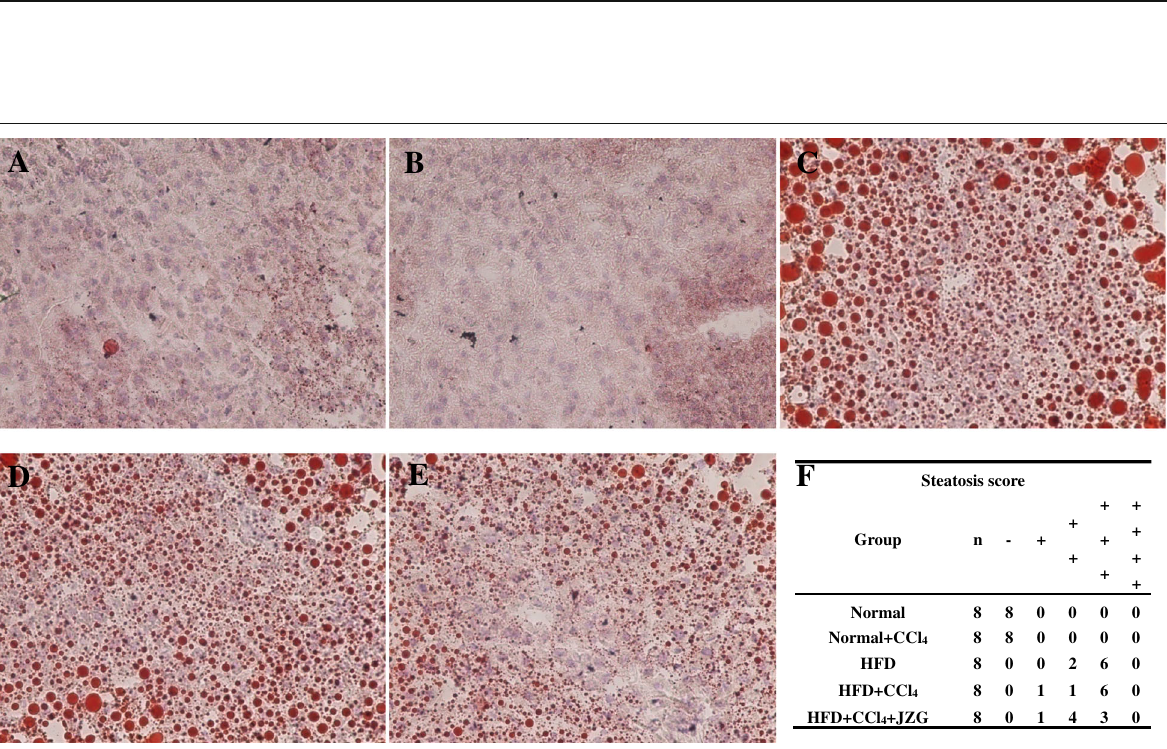
Fig. 3 Effect of JZG on hepatosteatosis: a - e Oil Red O Staining in liver tissue, the original magnification is 200×, a Normal group, b Normal+CCl 4 group, c HFD group, d HFD + CCl 4 group, e HFD + CCl 4 + JZG group, f Steatosis stage of